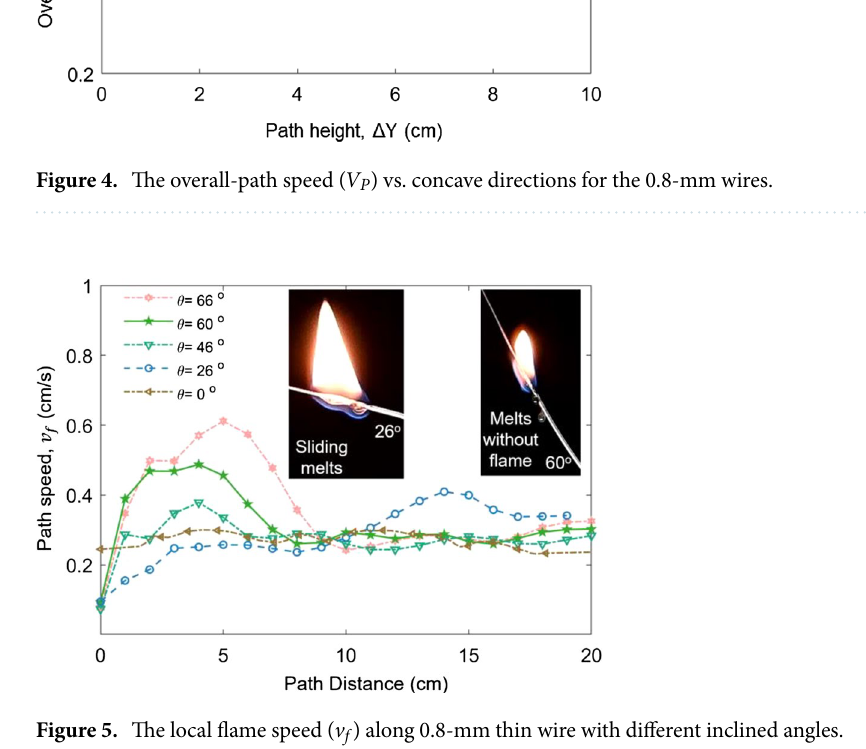
Figure 5. The local flame speed ( v f ) along 0.8-mm thin wire with different inclined